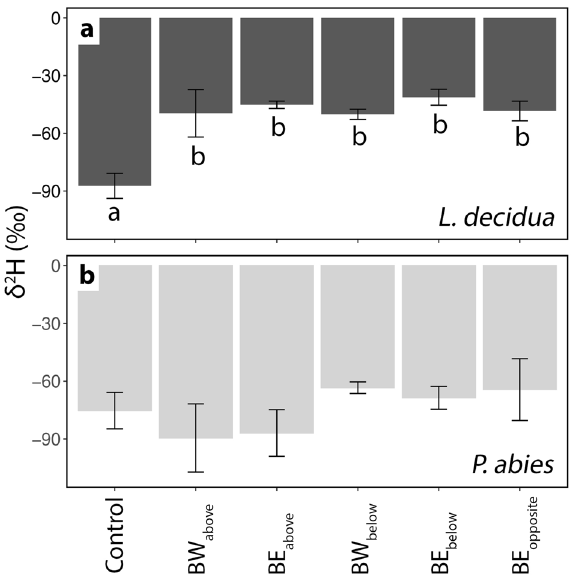
Figure 5. End-twigs δ 2 H analyses. δ 2 H analyses (‰) from the xylem of end-twigs (ca. 10 cm) collected at different positions within the crown of the same L. decidua ( a ) and P. abies ( b ) specimens used for cores (see Fig. 1) on April 25th, 2017. The Figure shows values from control specimens and from samples collected at different positions with respect to the labelled bag: branch above west (BW above ) and east (BE above ), branch below west (BW below ) and east (BE below ), and branch opposite east (BE opposite ) (see also Fig. 2a for sample nomenclature). Mean ± SE. Different letters indicate significant differences ( P < 0.05) between means. No difference was found in P. abies .